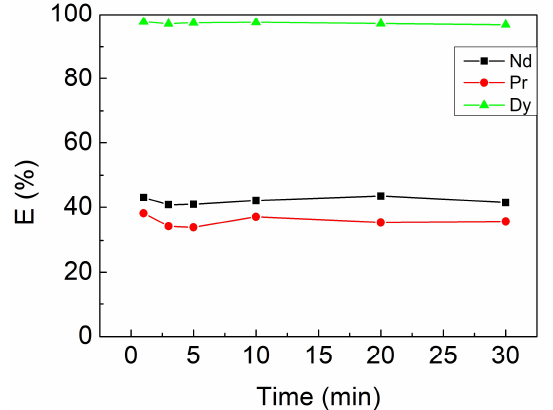
Figure 2. Extraction efficiencies at different contacting times. Fixed parameters: pH 5, 3 mM [Cyphos IL 104], O/A ratio of 1.